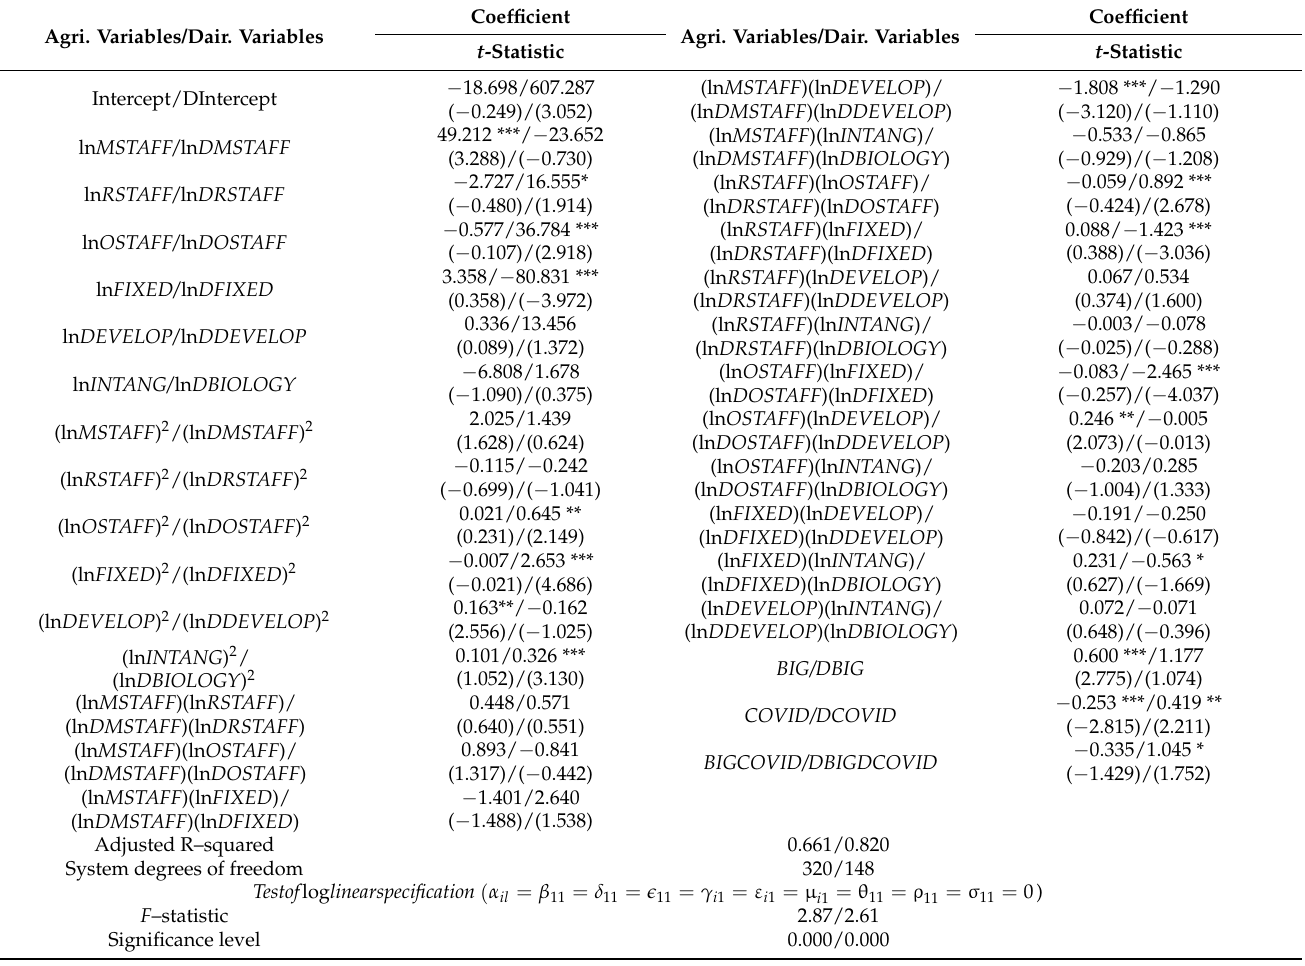
Table 3. Translog estimates (agriculture and dairy